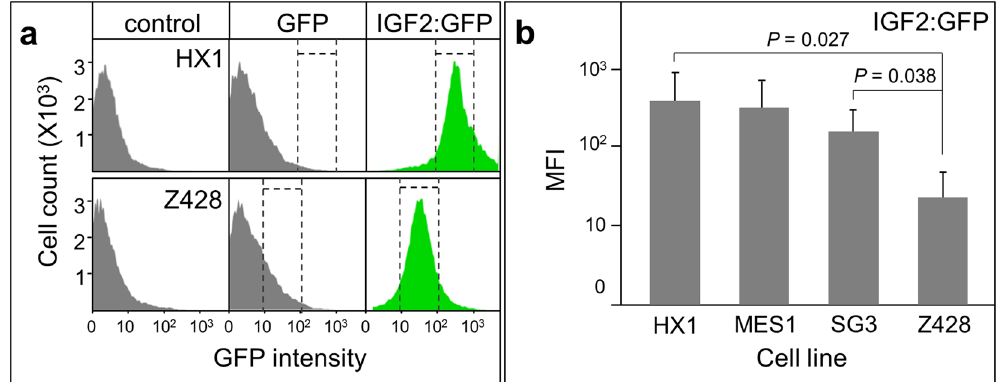
Figure 3. IGF2:GFP binding to stem cells. IGF2:GFP was incubated with medaka or zebrafish cell lines and the fluorescence of ligand was analyzed with flow cytometry. ( a ) Flow cytometric analysis of IGF2:GFP binding to medaka ES cell HX1 and zebrafish ES cell Z428. ( b ) Binding ability of IGF2:GFP to the stem cells presented by mean fluorescence intensity